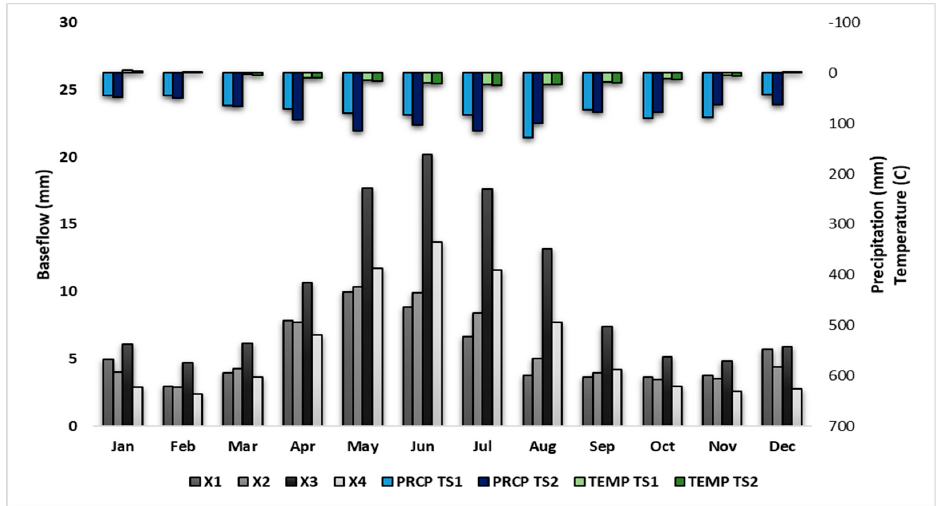
Figure 12. Monthly baseflow change for the UWBDR watershed under different scenarios.